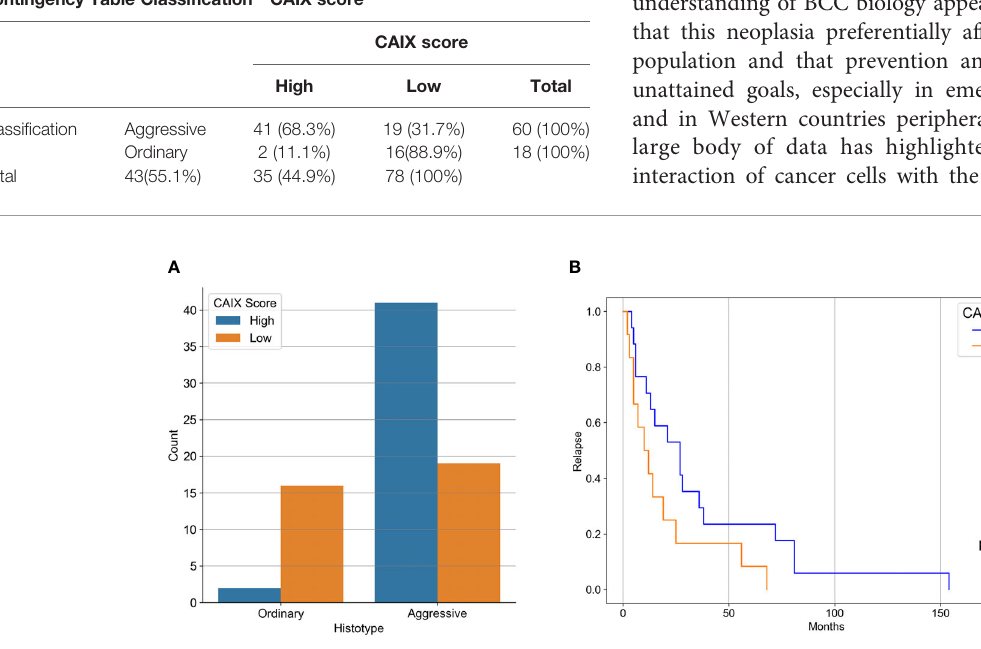
TABLE 4 | Contingency table of BCC histologic classi fi cation by CAIX score. Contingency Table Classi fi cation * CAIX score